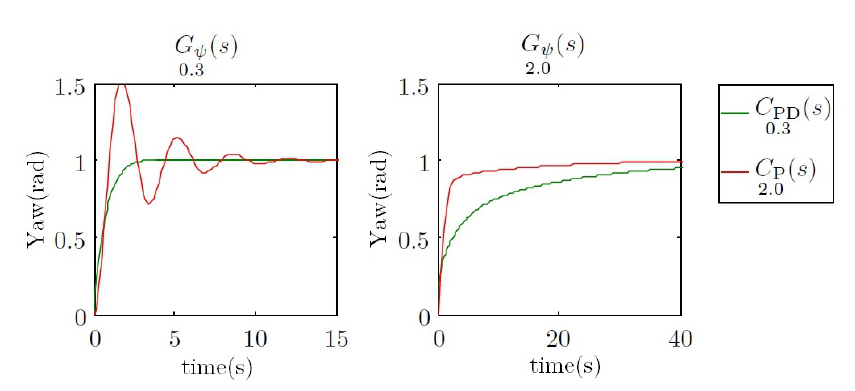
Figure 9. Step response of the systems G ψ 0.3 ( s ) and G ψ 2.0 ( s ) using the controllers C PD 0.3 ( s ) and C P 2.0 ( s ) in a feedback loop. The two time scales are different for a better response appreciation between controllers at different